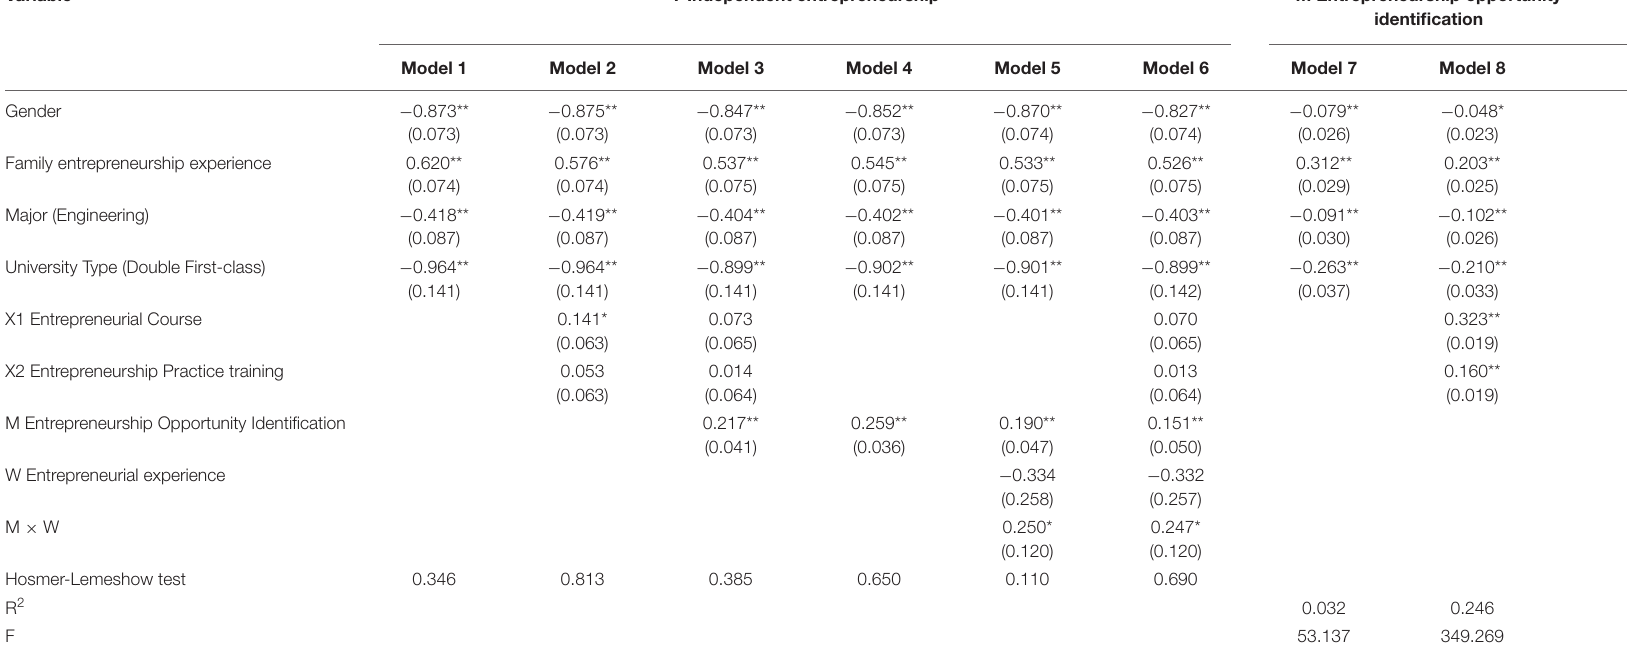
TABLE 10 | Multilevel regression